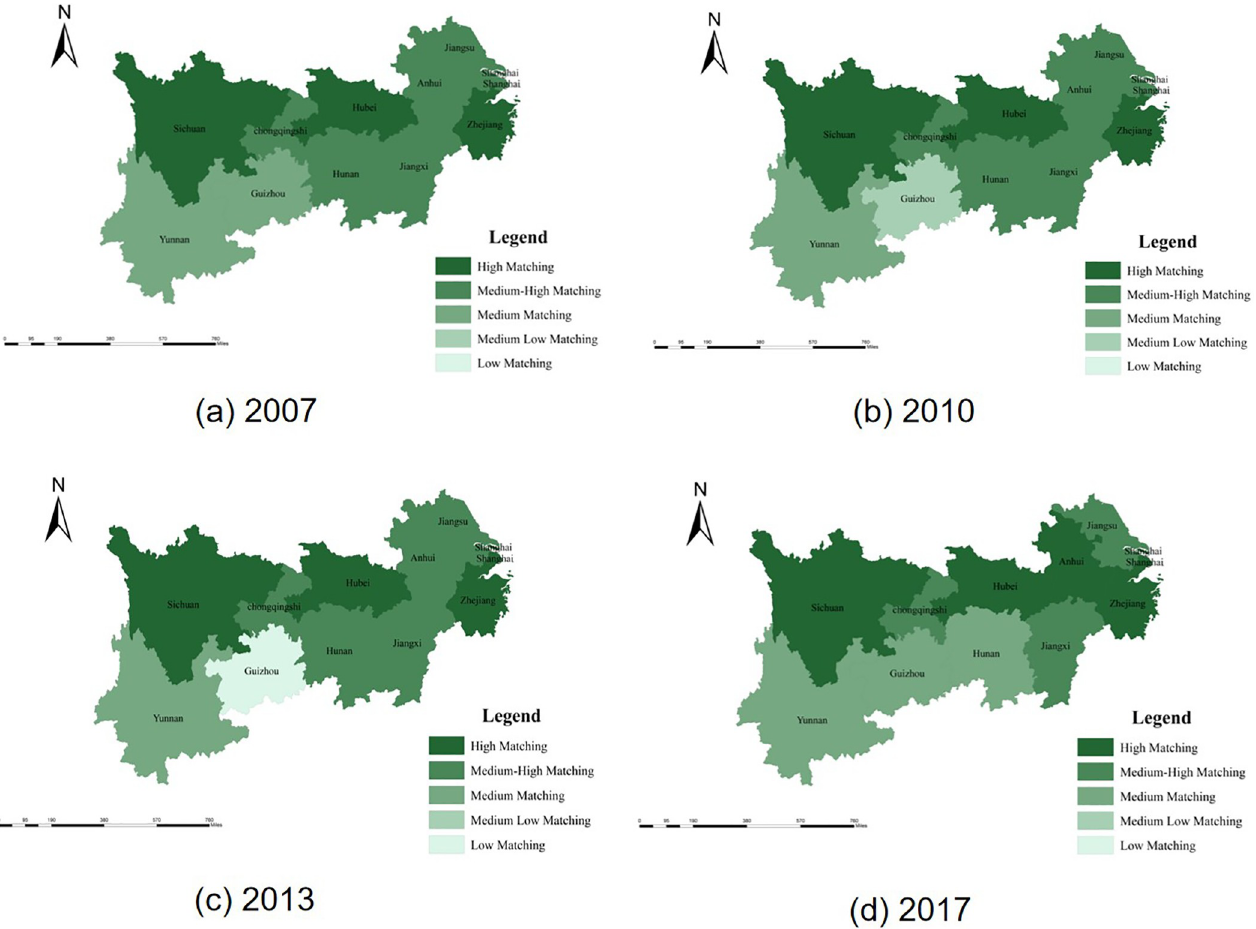
Fig 5. Space matching evaluation of the population-land urbanization in the YEB in 2007 to 2017. a. 2007. b.2010. c.2013. d.2017. (Quoted from the Tianditu map. Source of base map: the open source map data service provided by the National Platform for Common GeoSpatial Information Services (https://